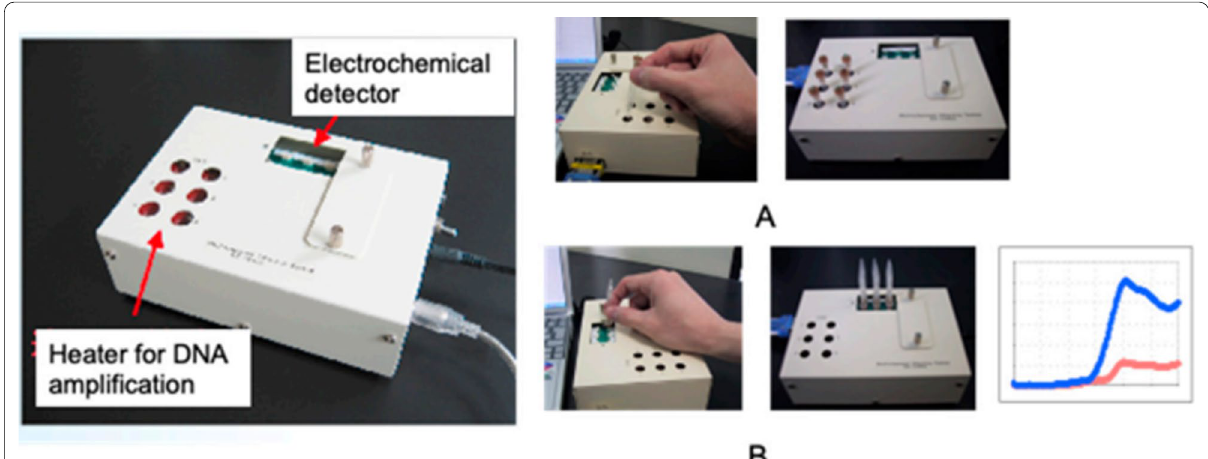
Fig. 3 Schematic illustration of the electrochemical DNA detector with heater ( A ); Sensing DNA after operation of DNA stick ( B ) (Tamiya 2022)